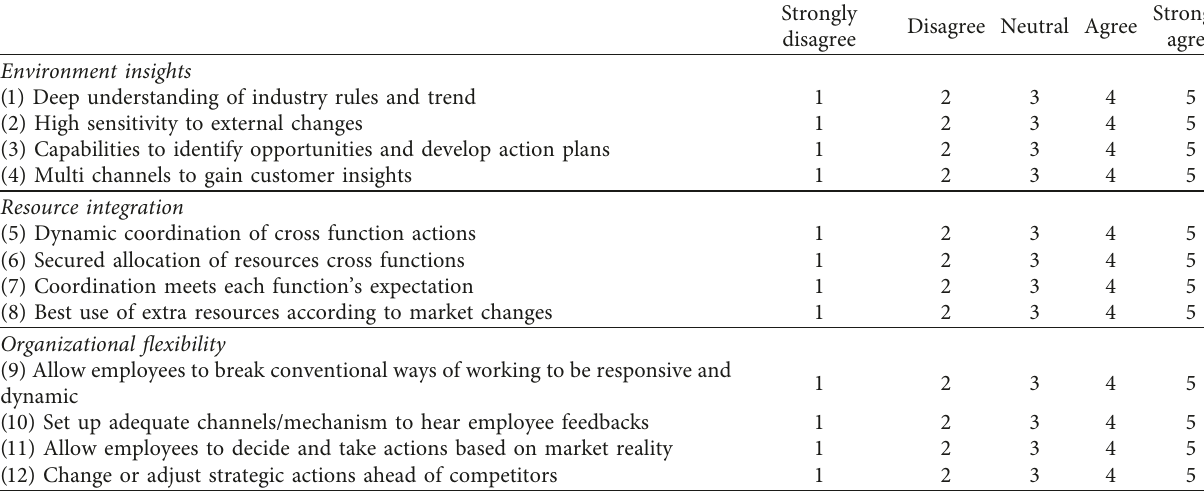
Table 10: Questions of dynamic capabilities.